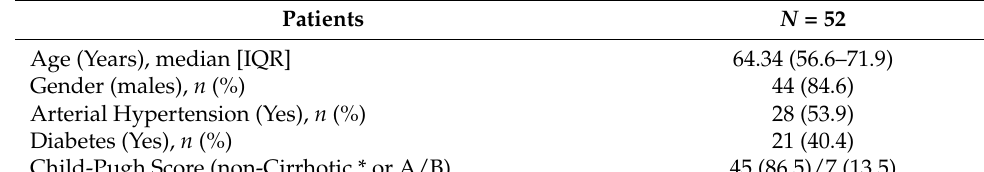
Table 1. Patient